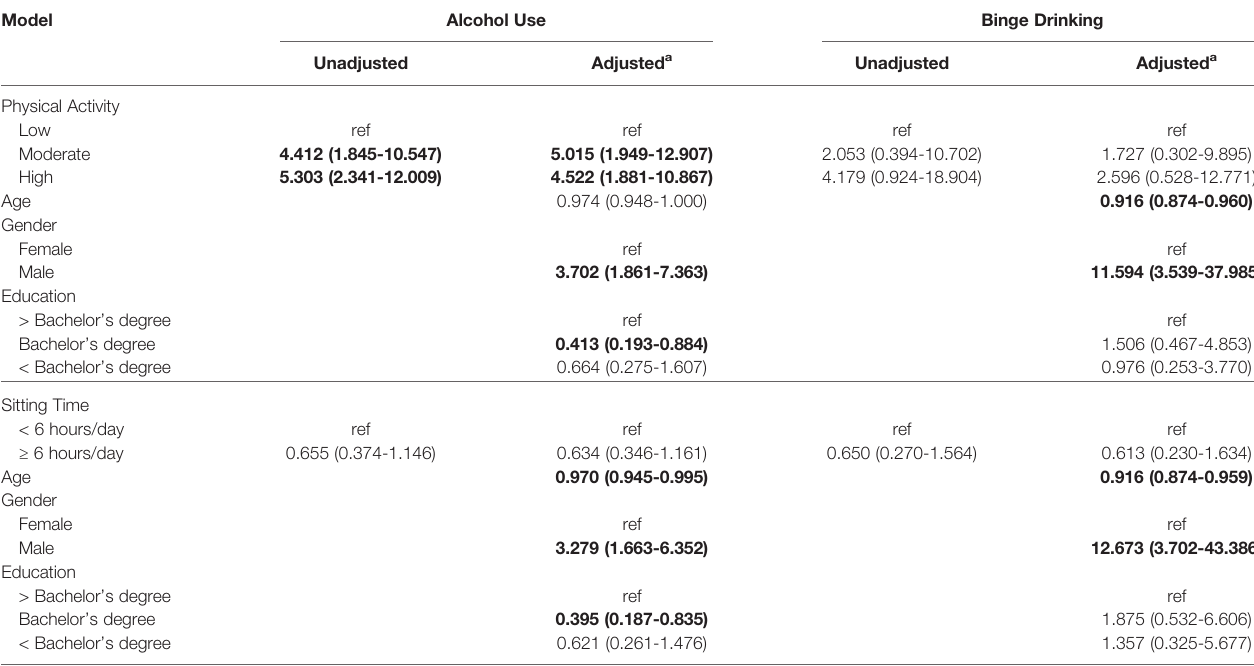
TABLE 2 | Associations between physical activity and sitting time and alcohol use in rural cancer survivors [OR (95% CI)].